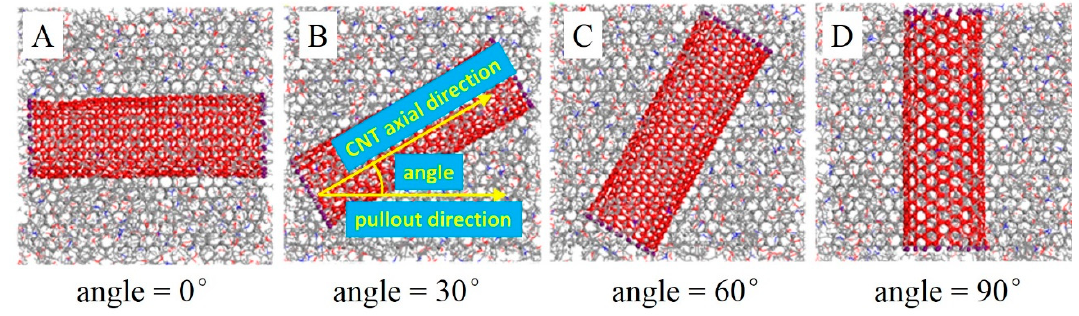
Figure 9. Equilibrium structures of composite models with different angles between the CNT (10, 10) axial direction and pullout direction—epoxy atoms are hidden.